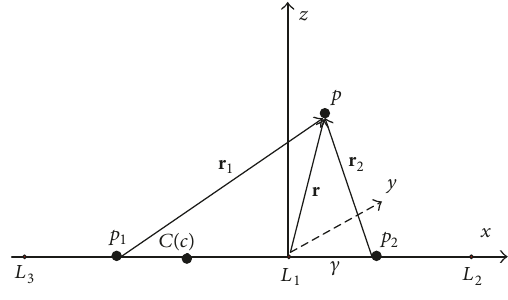
Figure 2: The 𝐿 1 -centered synodic reference